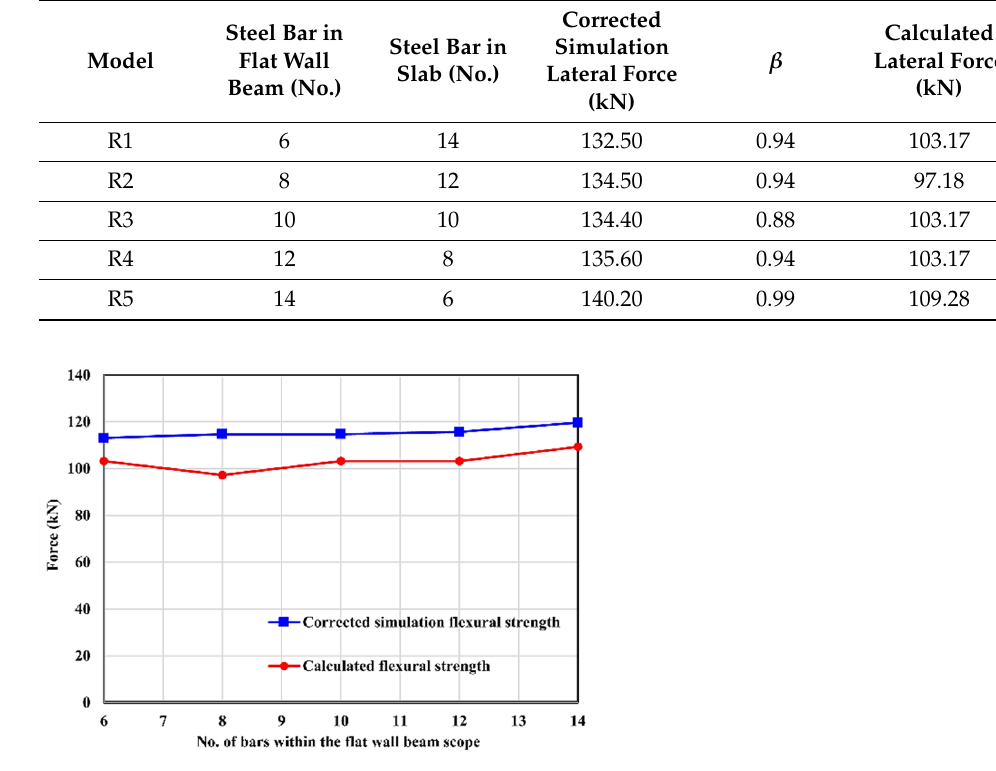
Table 3. FEM results for reinforcement distribution models.